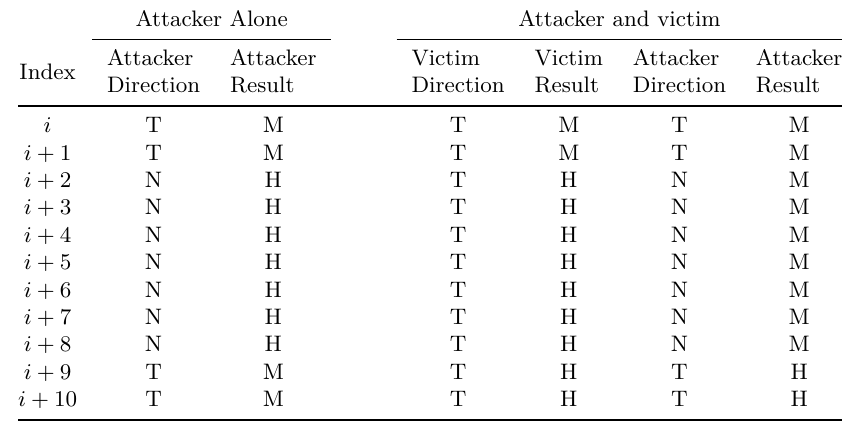
Table 1: The impact of the victim program on the misprediction result of the attacker program. M – misprediction, H – hit (correct prediction), N – not taken, T –